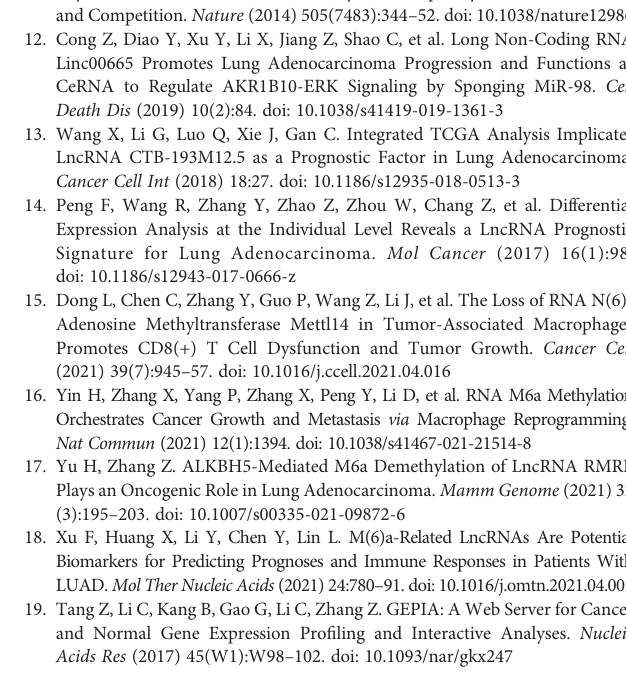
Supplementary Figure S2 | Expression changes of hub genes in Figure 2 network. Supplementary Figure S3 | Visualization of ATM-related mutations in OncoVAR. Supplementary Figure S4 | Intersection of lncRNAs between m6A-related lncRNA-TF network and ceRNA-based lncRNA-TF network. Supplementary Table S1 | The raw expression data of TCGA LUAD